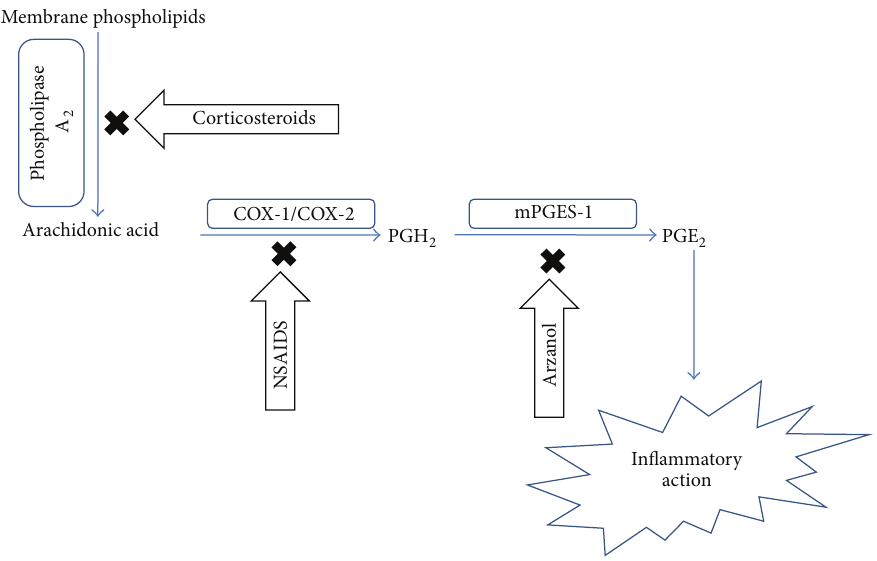
Figure 6: Site of action of arzanol and other anti-inflammatory